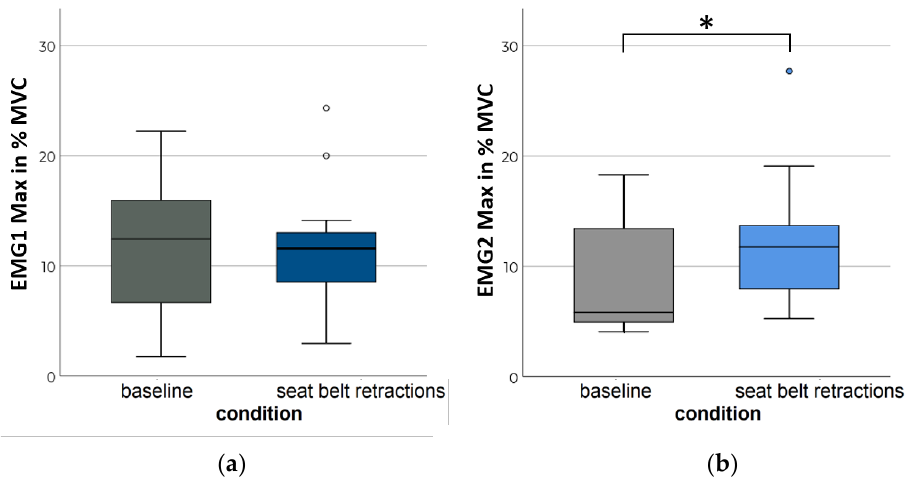
Figure 10. Distribution of maximum neck muscle tension in the baseline and with seat belt retractions: ( a ) EMG1; ( b ) EMG2. * p < 0.05.